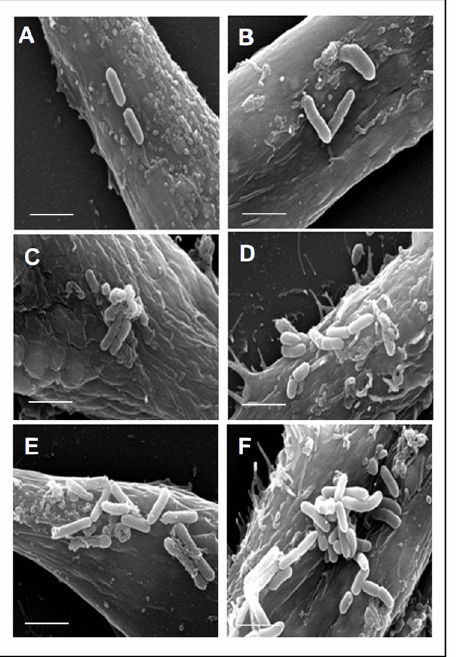
Figure 3. Scanning electron micrographs demonstrating inter- action of P.aeruginosa with HMEECs. Epithelial cells were infected with P. aeruginosa for 30 min (A), 1h (B), 1.5h (C), 2h (D), 4h (E) and 8h (F) and then subjected to SEM. Large number of bacteria were seen on the surface of HMEECs at 8h post-infection. Results are representative of four independent experiments carried out in triplicate. Scale bars 2 m m.